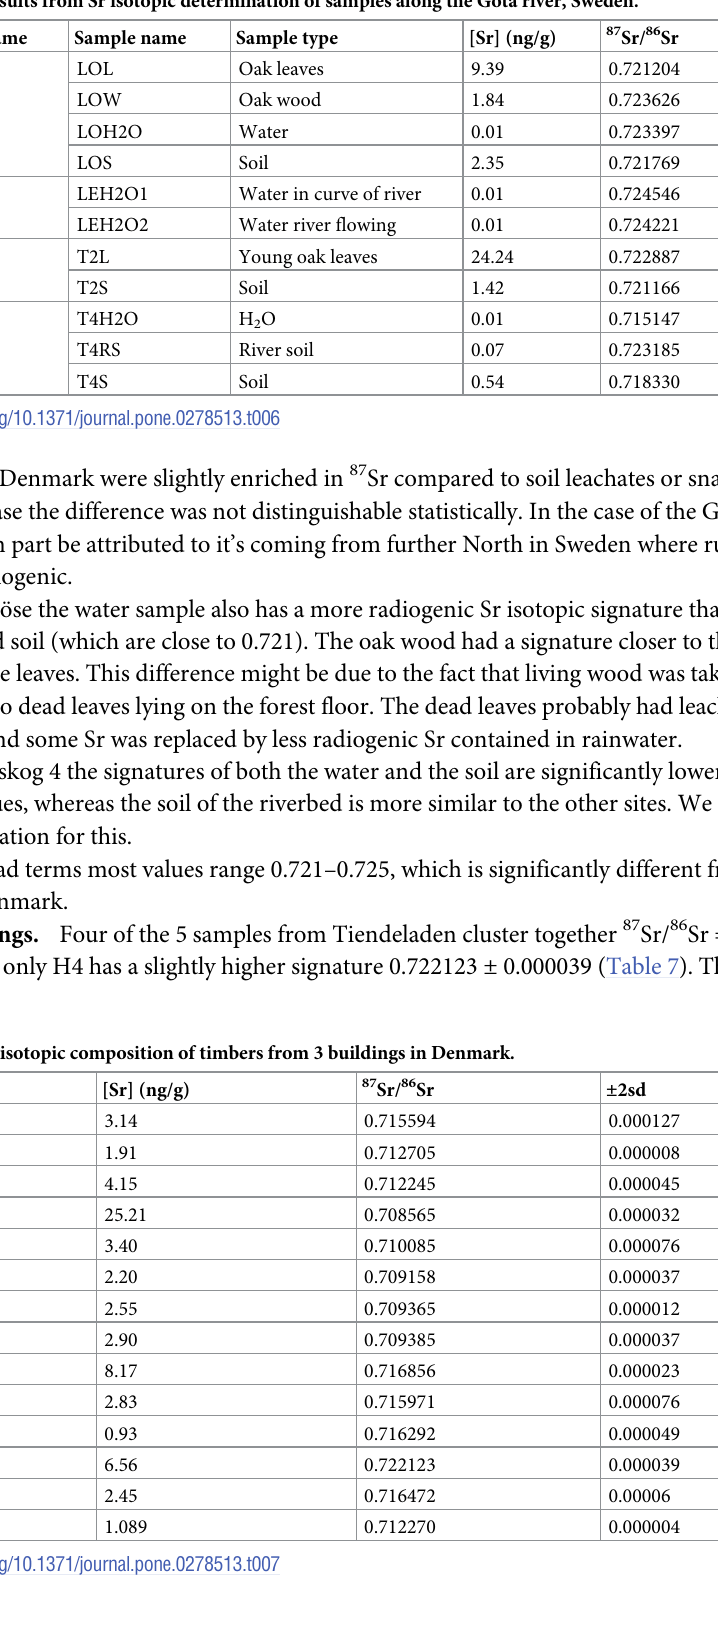
Table 6. Results from Sr isotopic determination of samples along the Gota river, Sweden.